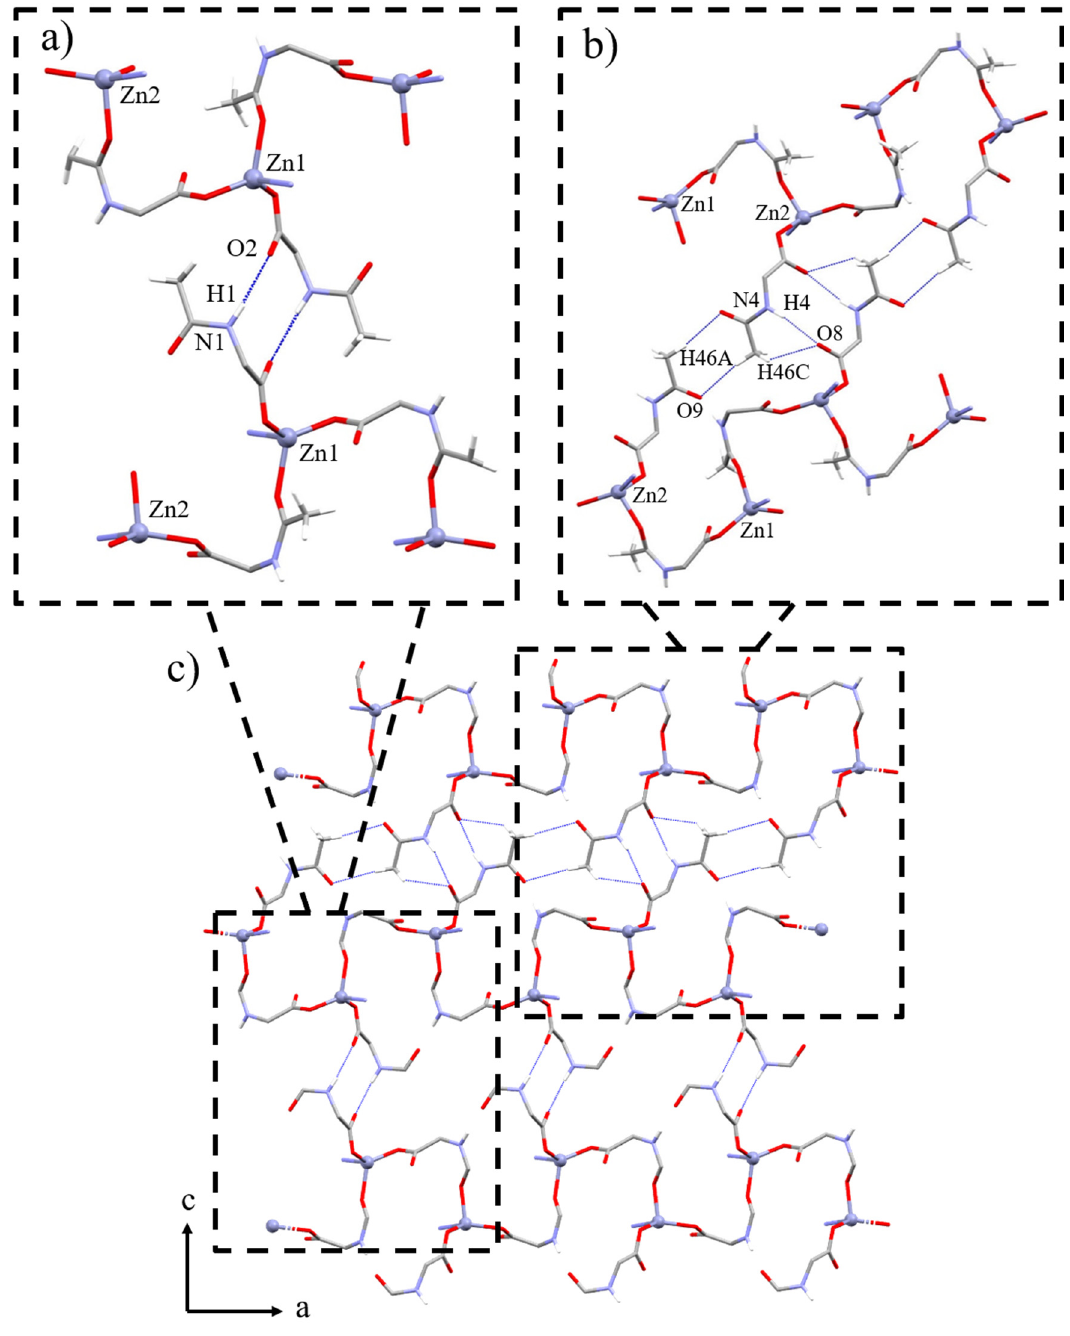
Figure 2. In detail view of: ( a ) N-H ··· O interactions. ( b ) N-H ··· O and C-H ··· O interactions through the polymeric chains. ( c ) General view of the 2D layers formed by intermolecular interactions along the ac plane in 1 . The phenyl, pyridyl and other atoms which do not participate in any of the mentioned interactions have been omitted for clarity.